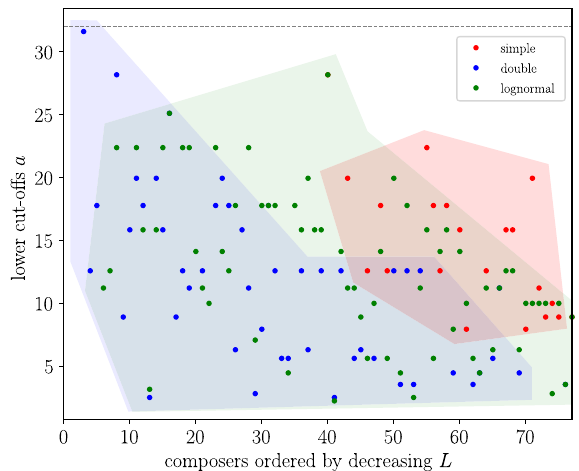
Figure 6. Results for each composer of the lower cut-off for each fit, when this is not rejected. Shadowed regions group the results for each fit. A lower value of a implies a larger fitting range; the distribution with the lowest value of a is the preferred best fit for each composer.